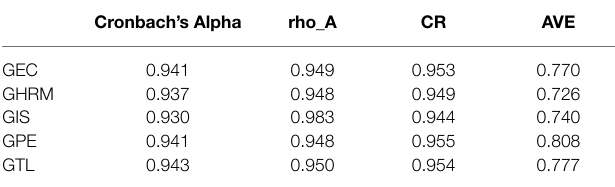
TABLE 4 | Convergent validity (CV) and internal consistency reliability